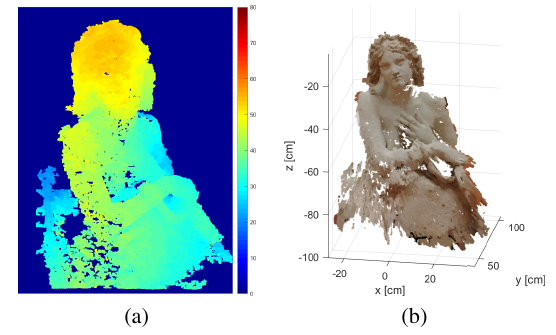
Figure 7. (a) Disparity map and (b) 3D model obtained from the stereo images shown in Fig. 4 after removing undesired points.